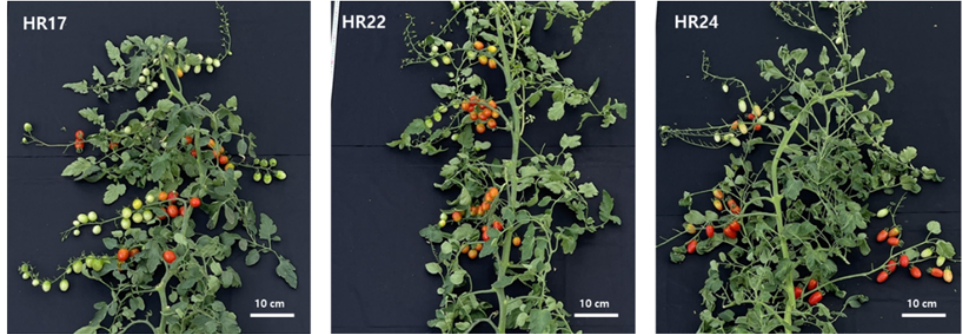
Figure 1. Fruit phenotypes of HR17, HR22, and HR24 grown in control ‐ condition greenhouse on 57th day after treatment.